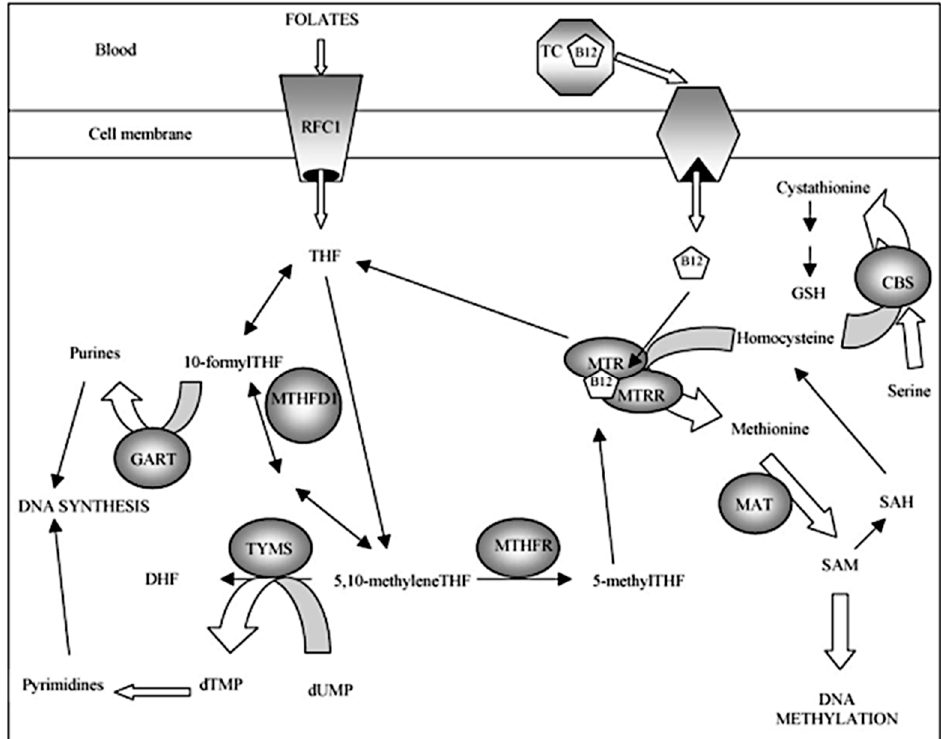
Figure 1. Simplified overview of the human folate metabolic pathway [10]. Enzymes: CBS: cystathionine b-synthase; GART: phosphoribosyl glycinamide transformylase; MTHFD1: methylenetetrahydrofolate dehydrogenase; MAT: methionine adenosyltransferase; MTHFR: methylenetetrahydrofolate reductase; MTR: methionine synthase; MTRR: methionine synthase reductase; RFC1: reduced folate carrier; TC (TCN2): transcobalamin; TYMS: thymidylate synthase. Metabolites: DHF: dihydrofolate; GSH: glutathione; THF: tetrahydrofolate; dTMP: deoxythymidine monophosphate; dUMP: deoxyuridine monophosphate; SAH: S-adenosyl homocysteine; SAM: S-adenosylmethionine. Cofactors: B12: vitamin B12 or cobalamin.